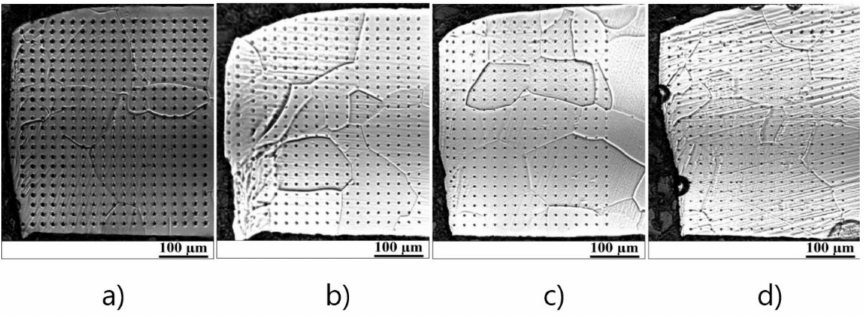
Figure 7. Grain structure in combination with a matrix of nanoindentation measurements carried out at vicinity of cutting edge of samples with ( a ) 1%, ( b ) 3%, ( c ) 5%, and ( d ) 7% of cutting clearance before annealing.